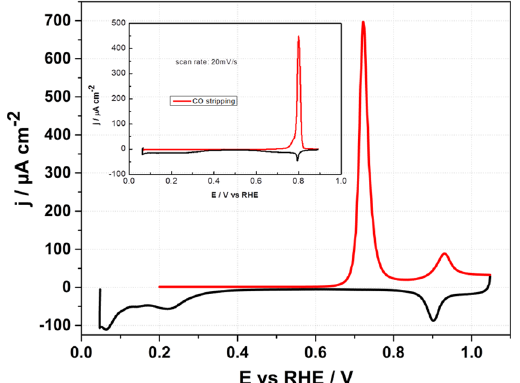
Figure 9. CO stripping voltammogram of Ir(111) after the CO displacement at 0.2 V vs RHE in 0.1 M HClO 4 (pH = 1). The red line represents the CO stripping voltammogram and the black line shows the cathodic scan after the stripping. Scan rate 50 mV/s. Inset shows the corresponding voltammogram for the CO stripping from the Pt(111) electrode in 0.1 M HClO 4 .